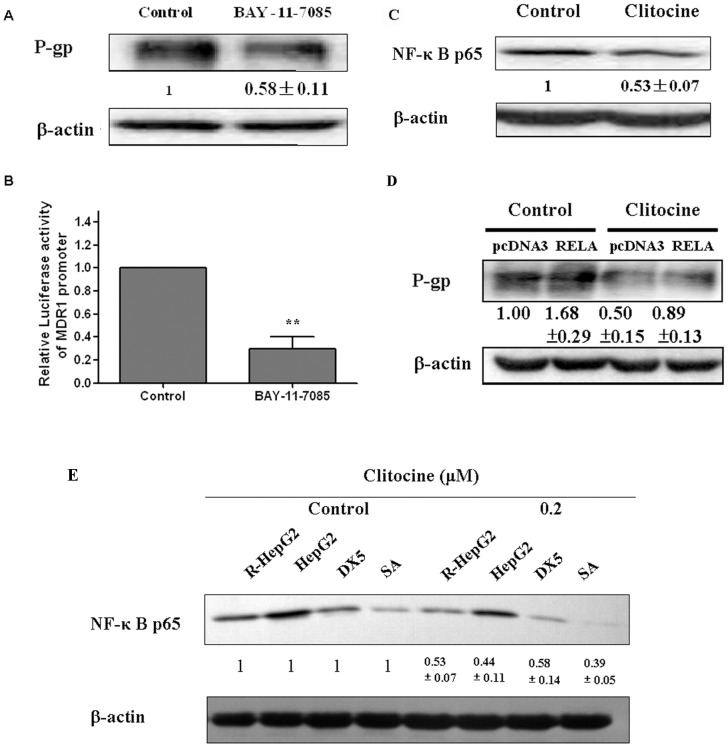
NF-κB mediated the clitocine suppression on MDR1.(A) P-gp in R-HepG2 cells with BAY-11-7085 (10 µM) treatment was assessed by Western blot assay. After treatment with 10 µM BAY-11-7085 for 48 h, P-gp protein level in R-HepG2 cells was measured by Western blot analysis. (B) The relative luciferase activity of reporter carrying the full length MDR1 promoter was determined by Dual-Luciferase Reporter Assay System. R-HepG2 cells were transiently transfected with full length MDR1 promoter reporter followed by treatment with 10 µM BAY-11-7085 for 24 h. After that the cells were lysed and the luciferase activity measured. Data are mean ± SD, N = 3. **
P<0.01 vs. control. (C) After treatment with 0.2 µM clitocine for 48 h, Western blot assay was performed in R-HepG2 cells. (D) R-HepG2 cells were transiently transfected with pcDNA3-RELA and empty pcDNA3 (negative control) followed by treatment with 0.2 µM clitocine for 48 h. P-gp protein level was measured by western blot analysis. Data are mean ± SD, N = 3. (E) After treatment with 0.2 µM clitocine for 48 h, Western blot assay was performed in R-HepG2, HepG2, MES-SA and MES-SA/Dx5 cells to measure the NF-κB p65 level.